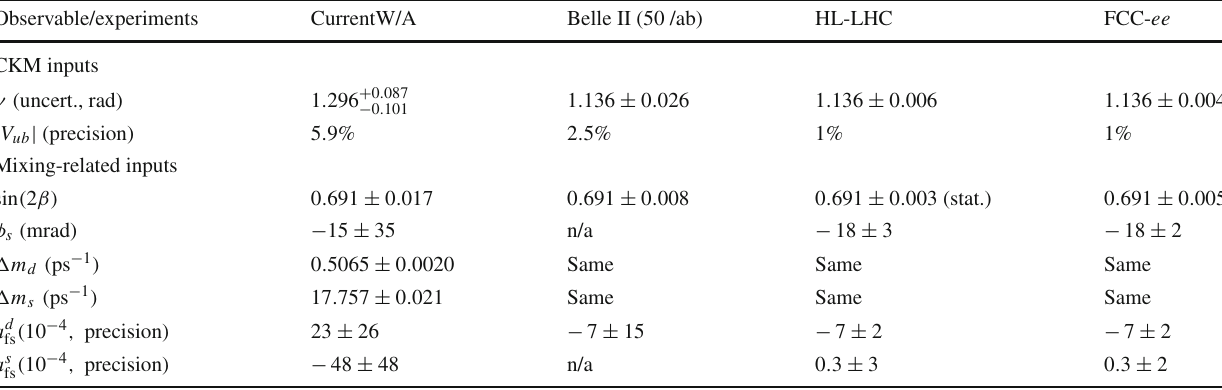
Table 7.3 List of inputs useful to constrain NP in (cid:4) F = 2 quark transitions and comparisons of the projected precisions of the Belle II, HL-LHC and FCC-ee experiments. The HL-LHC estimates [194] cor- respond to the combined projections for 300 fb − 1 (LHCb upgrade) and 3 ab − 1 (ATLAS and CMS). The central values for the angles are scaled